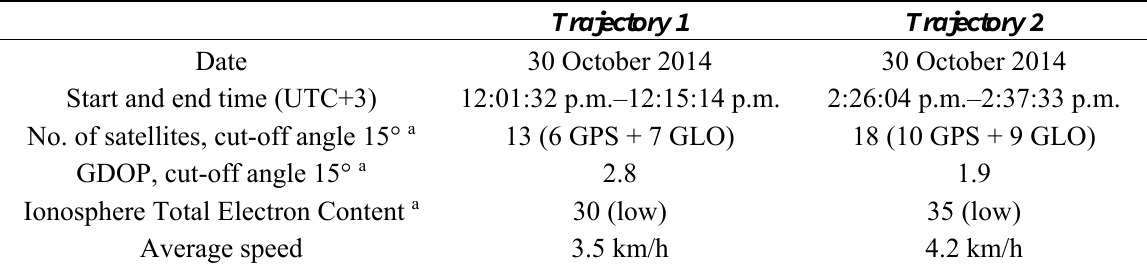
Figure 2. The reference trajectory (red) and the reference trees (green). Background orthoimage: National Land Survey Finland 2012. Table 1. Reference trajectory